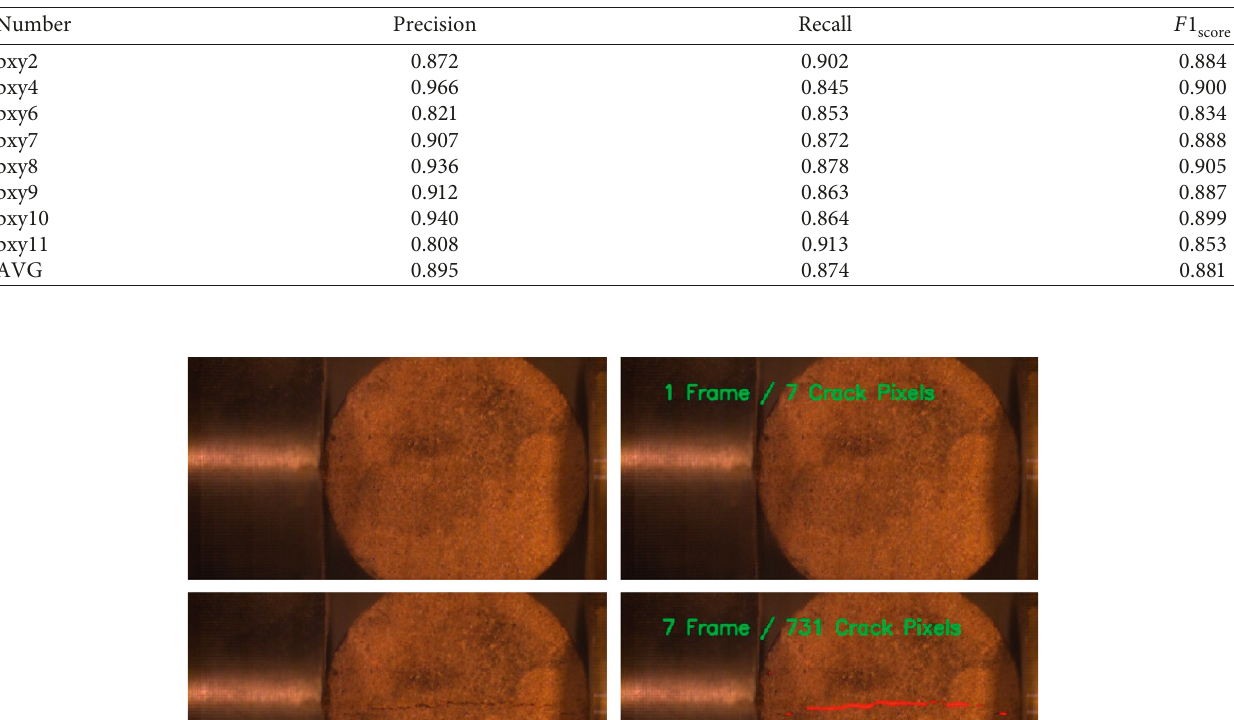
Table 2: The crack detection result of CrackSHPB model.